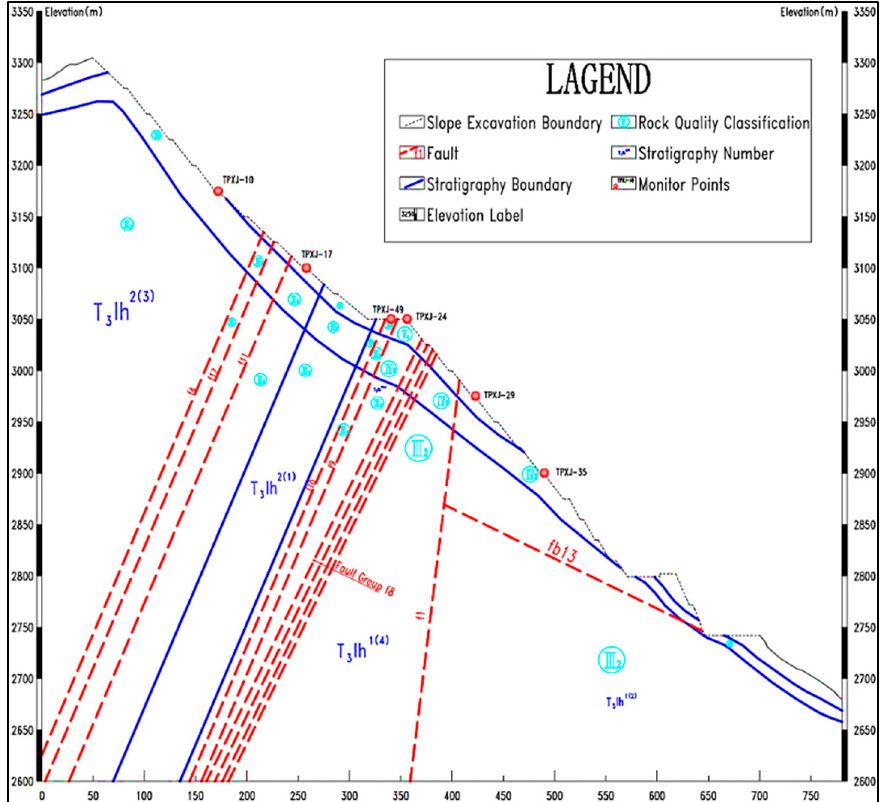
Figure 1. Typical profile of the inlet slope of the flood-discharge